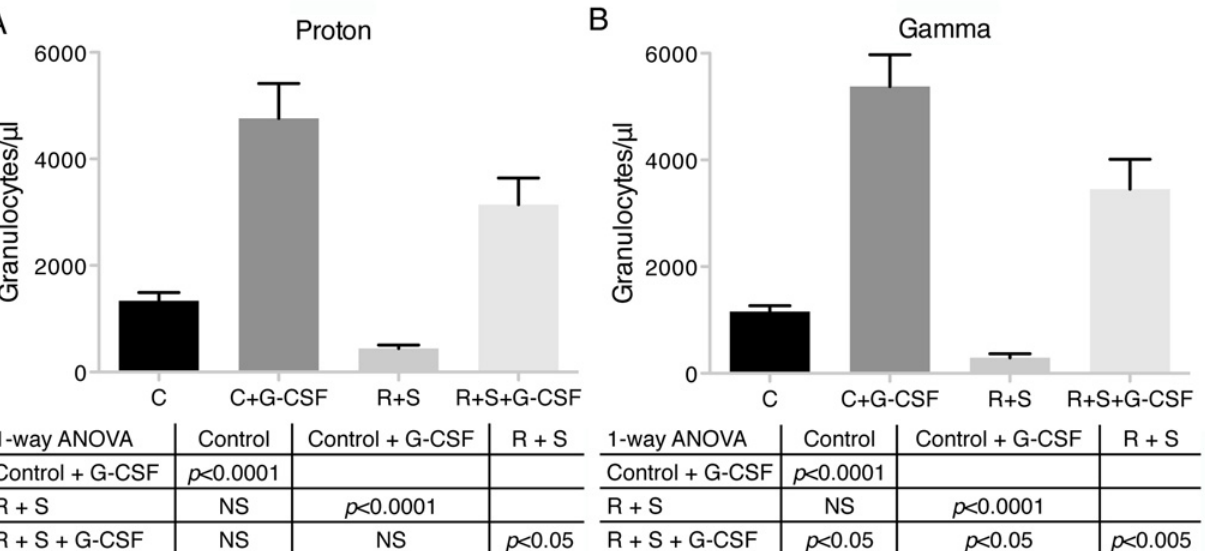
Fig 5. Effect of G-CSF on peripheral blood granulocyte counts during systemic bacterial challenge of irradiated and hindlimb suspended mice. Sets of 10 mice per treatment group were irradiated with 2 Gy of protons or gamma rays and hindlimb suspended or not and injected with PBS or G-CSF (600 μ g/kg) every 3 days. All groups were exposed to Pseudomonas aeruginosa by intraperitoneal injection and followed. After 5 days, the number of granulocytes, Ly-6G high, CD14-, and F4 – 80- in peripheral blood was calculated using AccuCount fluorescent particles. (A) proton treated and (B) gamma ray treated. C = control, R + S = irradiated + hindlimb suspended. Values are means ± SEM. One-way ANOVA with Bonferroni ’ s correction for multiple comparisons was used to test statistical significance.